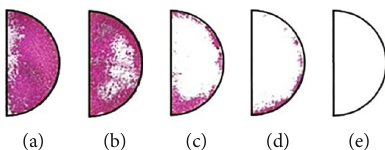
Figure 2: (a – e) Exemplary images of test specimen halves with dyed arti fi cial bio fi lm equivalent (ABE, layer 2) in test series TS 3 for planimetric measurement of remaining ABE depending on brushing strokes numbers after brushing: (a) after 5 brushing strokes, (b) after 10 brushing strokes, (c) after 15 brushing strokes, (d) after 25 brushing strokes, and (e) after 45 brushing strokes. Black frames on the images of test specimen halves were added to original images for better